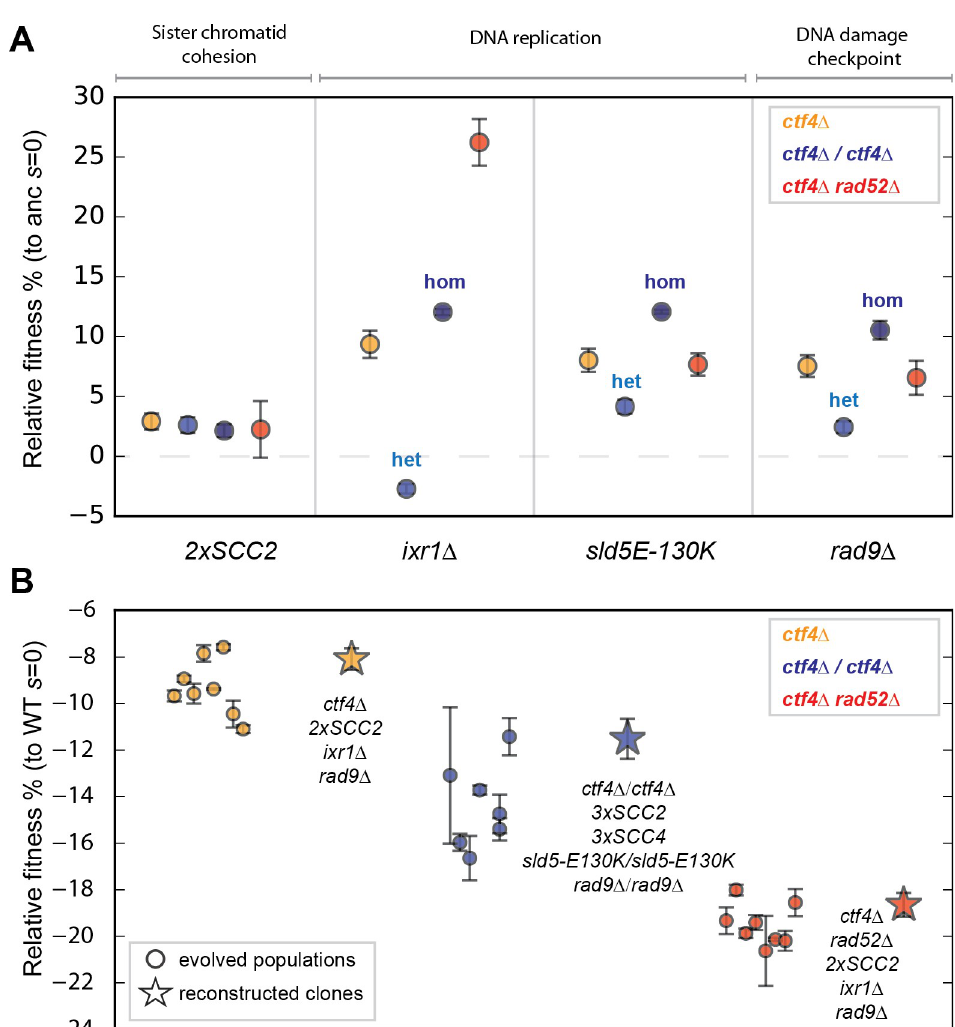
Fig 6. Reconstructed adaptive mutations can produce evolved fitness increases. (A) A subset of mutations affecting sister chromatid cohesion, DNA replication and DNA damage checkpoint were re-constructed in the the three ancestral strains that differed in their genomic features. The fitness of the re-constructed strains, relative to their respective ctf4 Δ ancestor cells ( s = 0) is depicted. For diploid strains, we replaced one (het) or two (hom) copies of the wild-type gene with the mutant allele. The fitness values shown here are reported in S7 Data. (B) Reconstructed strains carrying combinations of adaptive mutations affecting sister chromatid cohesion, DNA replication and DNA damage checkpoint recapitulate the fitness of their respective evolved populations after 1000 generations. The most frequently mutated gene affecting DNA replication was chosen for the reconstruction in individual features (e.g. IXR1 was mutated more often that SLD5 in haploids whereas the reverse was true in diploids). Fitness data of haploid strains (orange) is from [17]. The P-values reported in figures are the result of t-tests assuming unequal variances (Welch’s test). The fitness values shown here are reported in S7